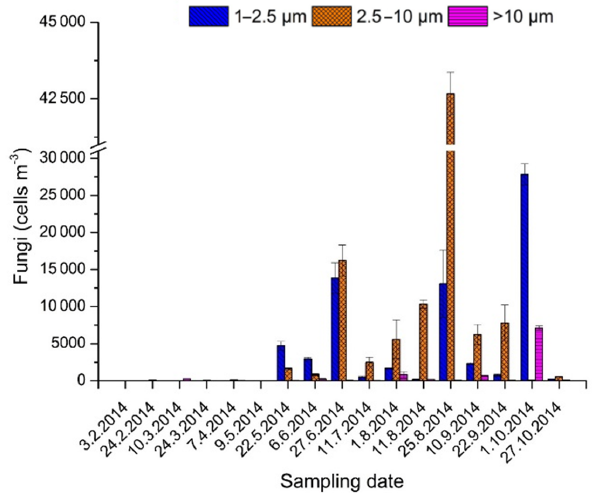
Figure 3. The number of fungal cells and spores over the sampling period, detected with qPCR from the filters of different particle size